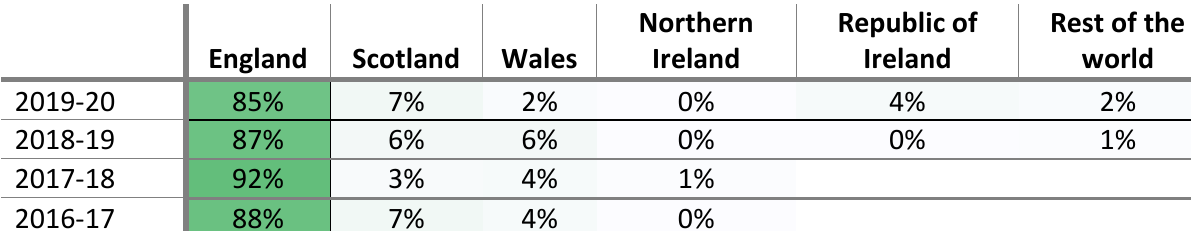
Turnover has been tracked by geographic source since 2017.